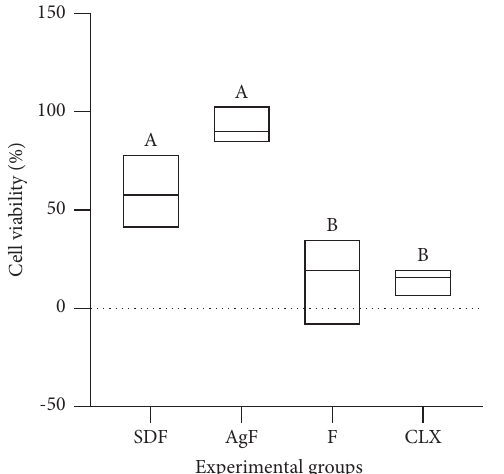
Figure 3: Cell viability percentage in relation to the control group. Different letters indicate a significant difference in intergroup